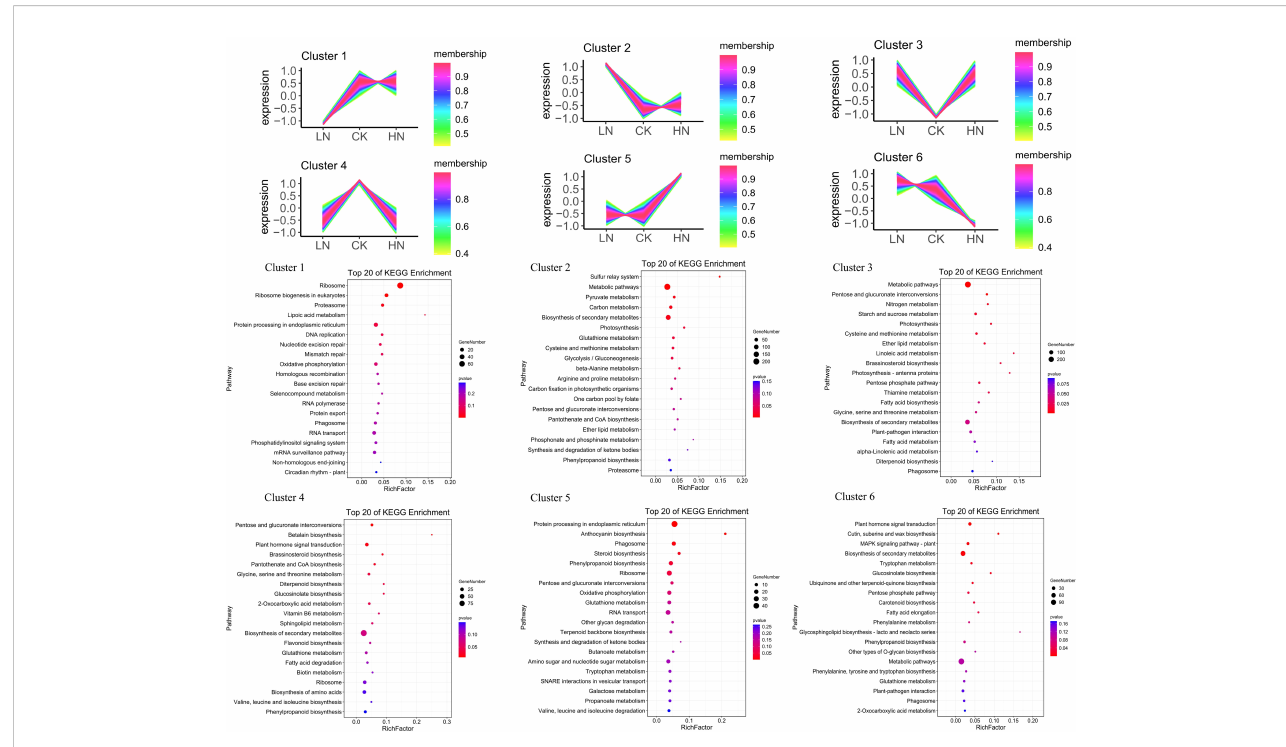
FIGURE 4 Nitrogen-responsive lncRNAs enrichment plot from KEGG pathway analysis for different coexpressed